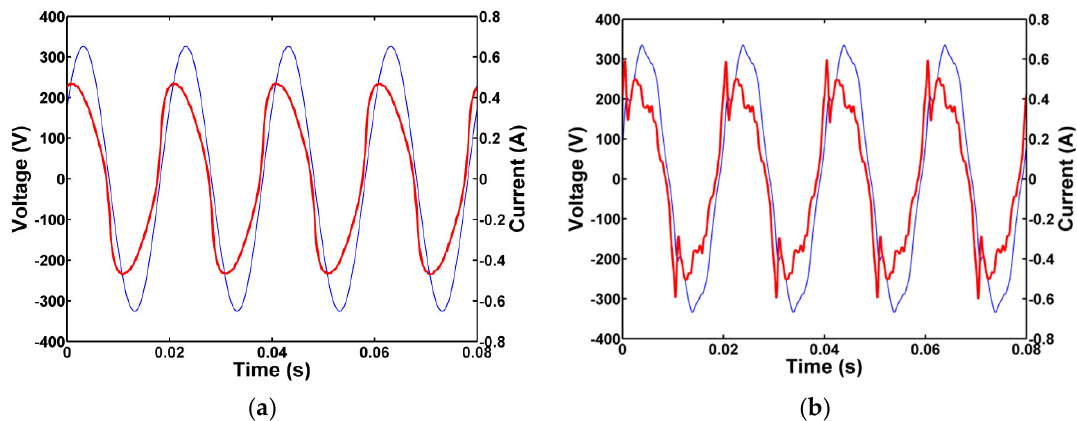
Figure 8. Waveforms of voltage and current for luminaire marked as LED2 for: ( a ) THD V = 0% and ( b ) THD V = 7.5%.